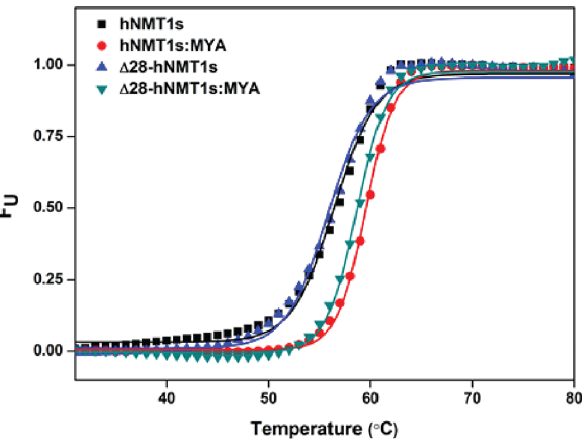
Fig 5. Thermal unfolding of variants hNMT1s and Δ 28-hNMT1s. The protein unfolding was monitored by the binding of Sypro orange dye to exposed hydrophobic patches upon thermal transition. The fluorescence signals were recorded at 3.3 μ M of protein and 5x SYPRO orange dye (either in presence or absence of 5 μ M MYA) in 50 mM sodium phosphate buffer (pH 7.0). The symbols represent the values obtained at each temperature and the fitted curves represent the Boltzmann fitting of the data as described under “ Materials and methods ” .